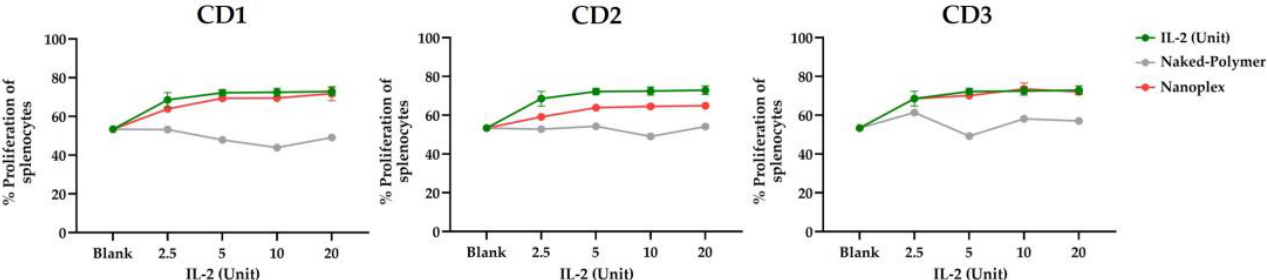
Figure 7. Dose dependent effect of CD polymers and naked IL-2 and IL-2 released from CD nanoplexes on splenocyte cell proliferation (n = 2, AVG ± SEM).